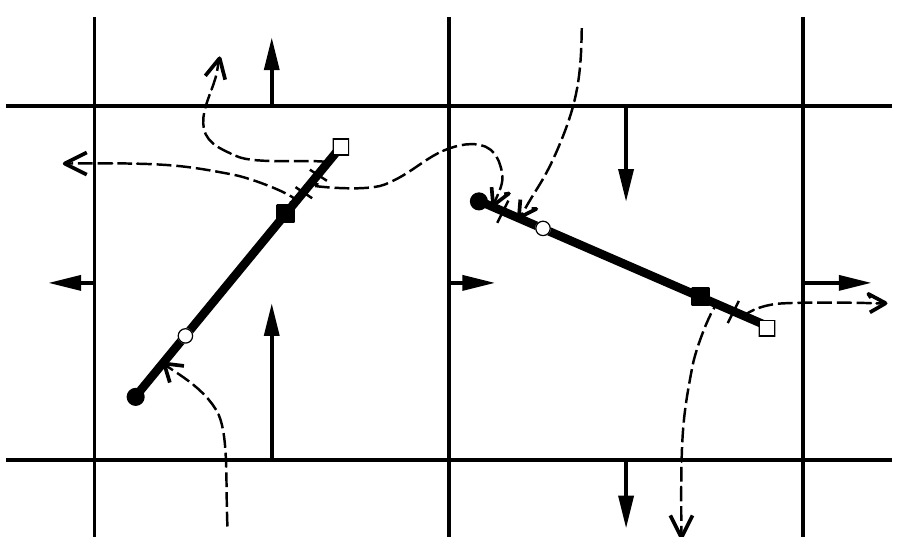
Figure 2. Illustration of splicing-induced transfers of LEM domain segments to adjacent LEM domains. Solid lines with arrows are face-normal velocities ¯ v that govern these transfers. Each 1D domain has an input end (circle) and an output end (square). Open and filled symbols demarcate the LEM domains before and after splicing. Segments transferred during splicing are separated by tick marks. Dashed curves with arrows indicate transfers between LEM domains in different